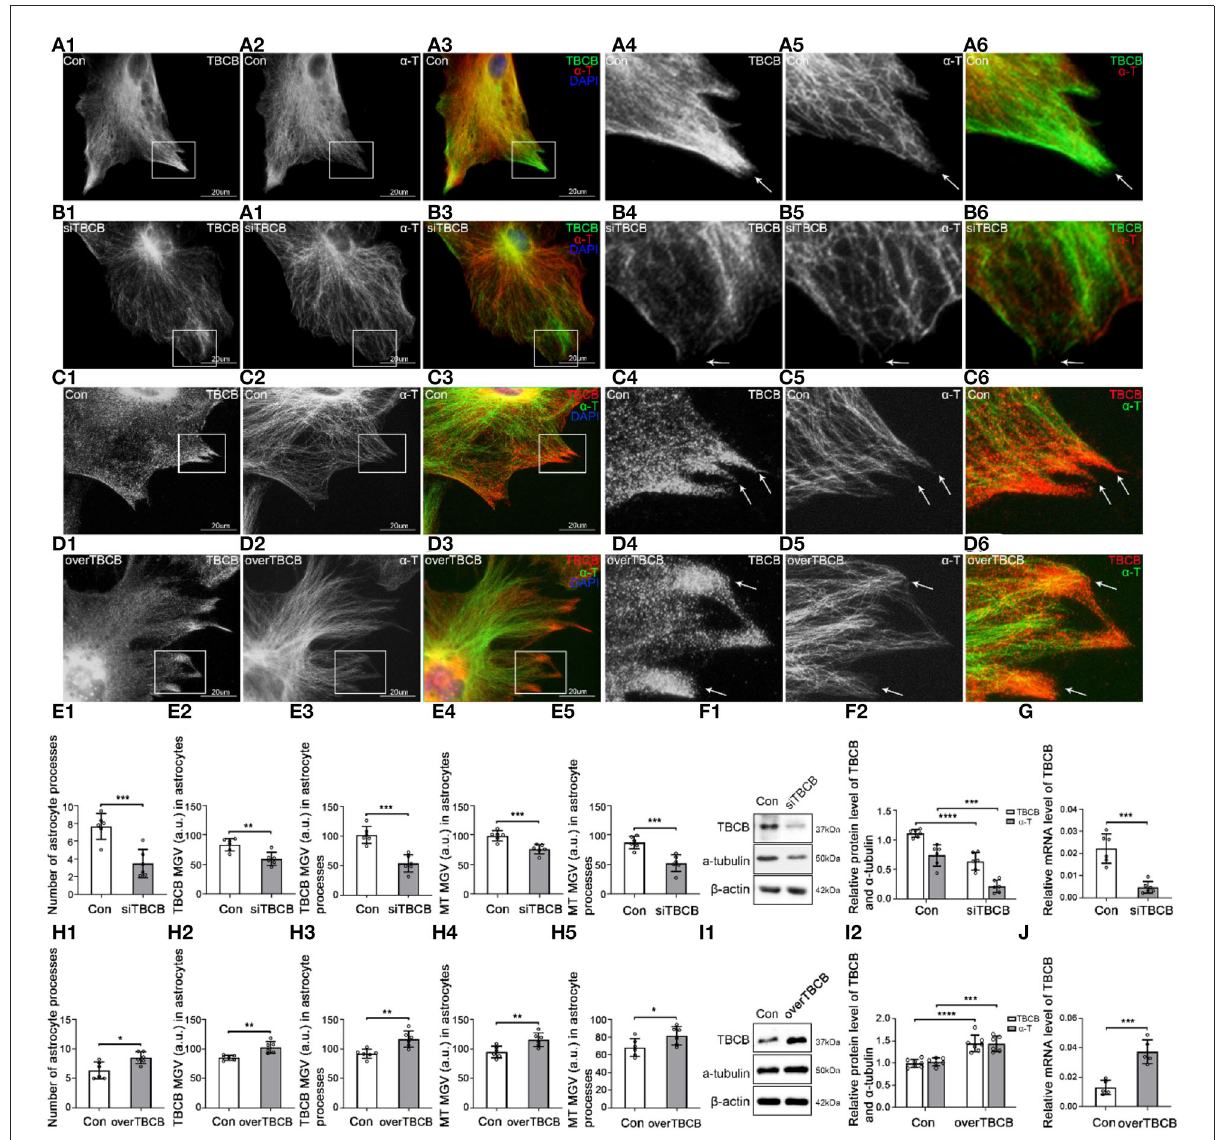
FIGURE2 Morphological changes in astrocytes and expression levels of TBCB and α -tubulin after TBCB was silenced or overexpressed. (A–D) Immunofluorescence showed that TBCB [ (A,B) green signal; (C,D) red signal] was co-expressed with α -tubulin [ (A,B) red signal; (C,D) green signal] in astrocytes both in the control group [Con (A) ] and in TBCB silence group (B) or TBCB overexpression group (D) . (E,H) The number of astrocyte processes and mean gray value (MGV) of TBCB and MT in astrocytes and its processes (MGV = Integrated Density/Area) after TBCB was silenced or overexpressed. (F,I) Western blot and (G,J) RT-PCR analysis of the levels of the α -tubulin protein and TBCB protein and its mRNA after TBCB was silenced or overexpressed compared with the control group ( n = 6, p < 0.05). (A–J) Number of panels. * p < 0.05, * * p < 0.01, * ** p < 0.001, * *** p <